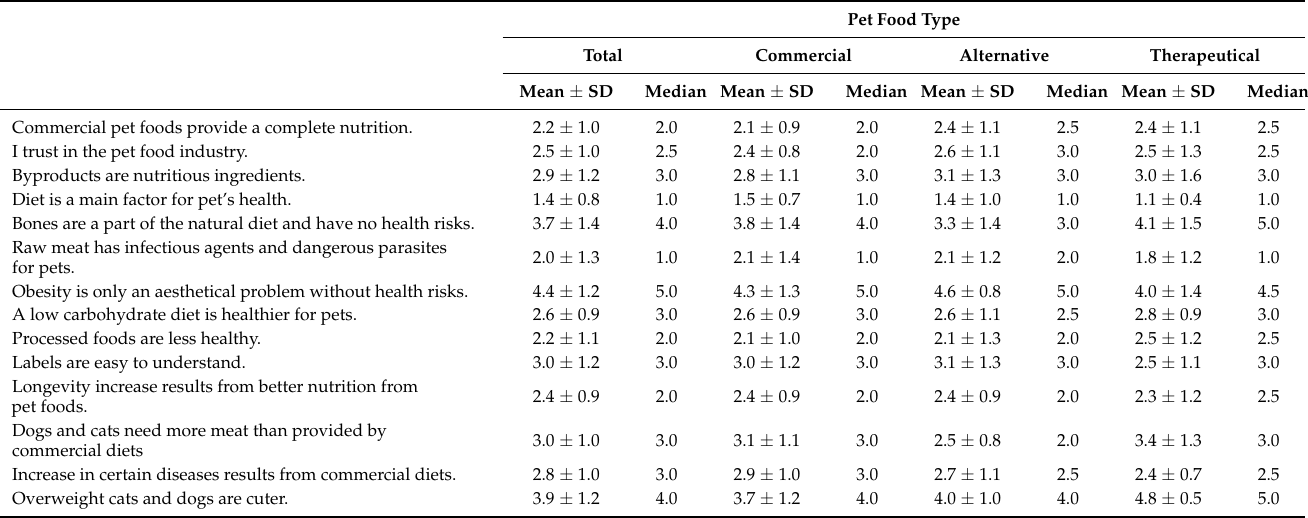
Table A4. Scores for pet owners about statements regarding attitudes towards feeding practices of their pets, in a scale varying from 1, strongly agree, to 5, strongly disagree.